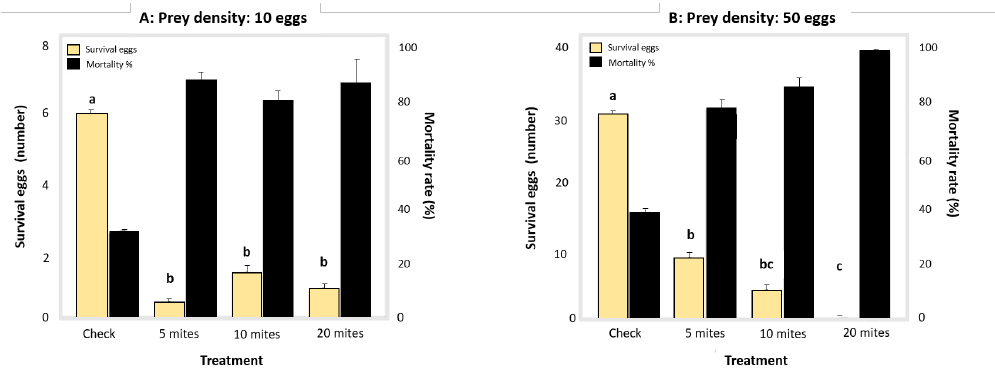
Figure 3. Mean values of surviving eggs (±SE) and mortality rate (±SE) at the infestation levels of 10 and 50 TCS eggs and doses of 0, 5, 10, and 20. Values with different letters denote significant differences at p = 0.5, using Wald test.